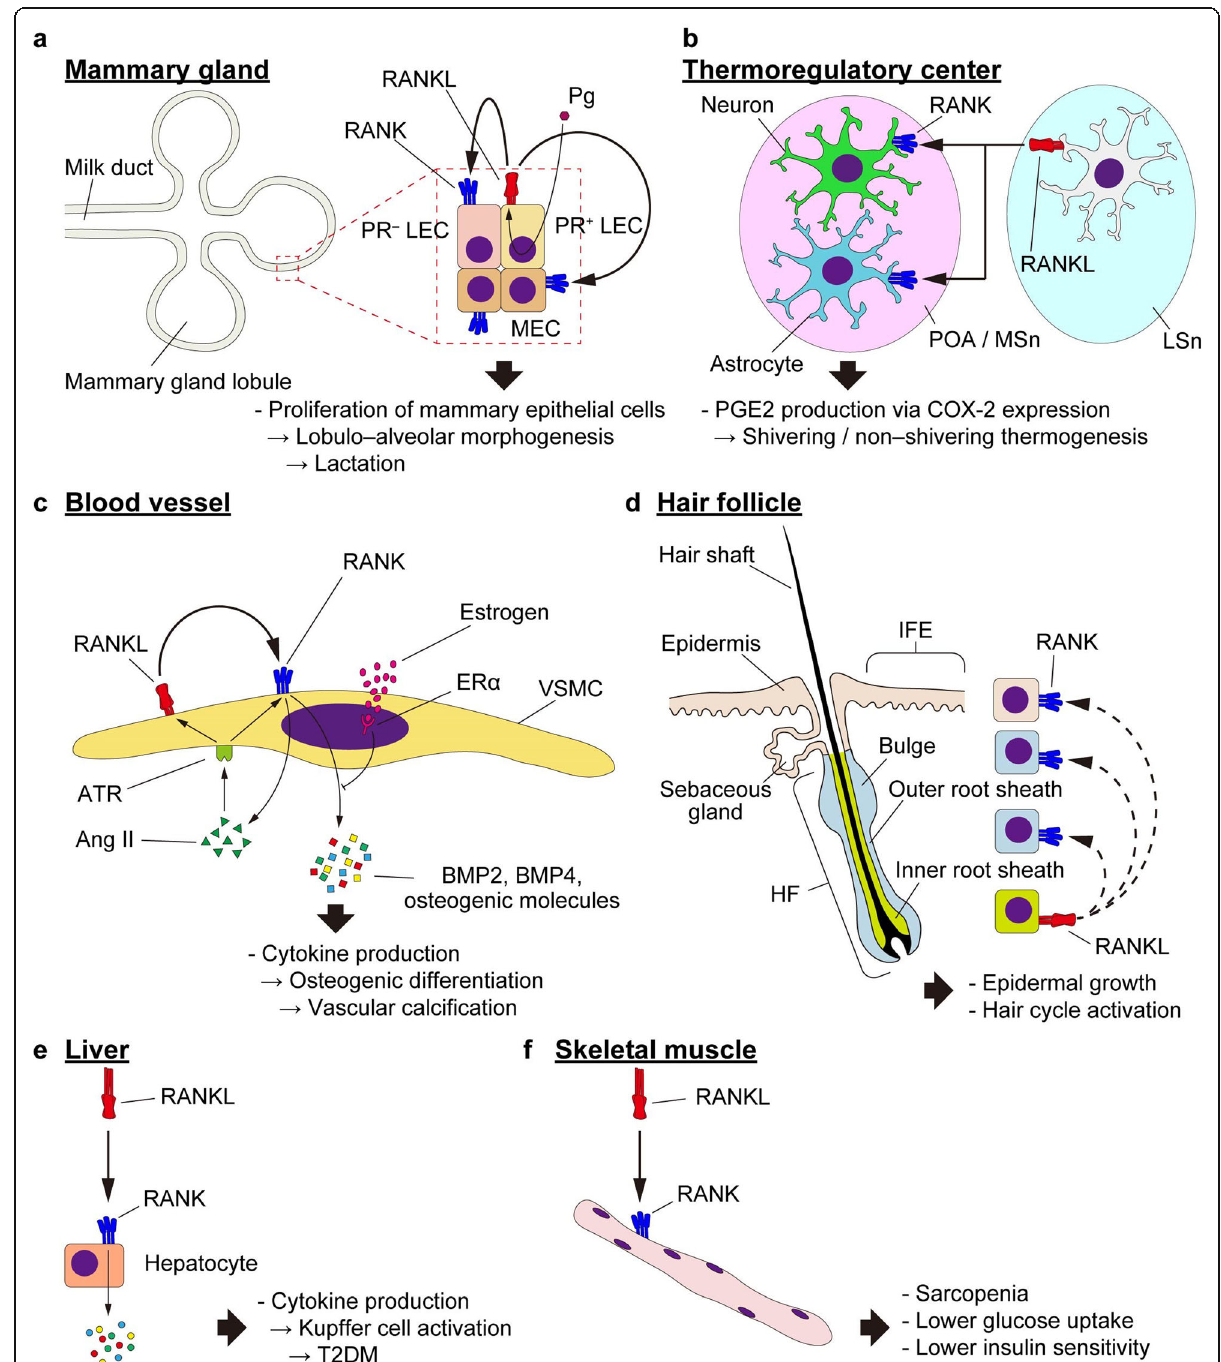
Fig. 3 (See legend on next